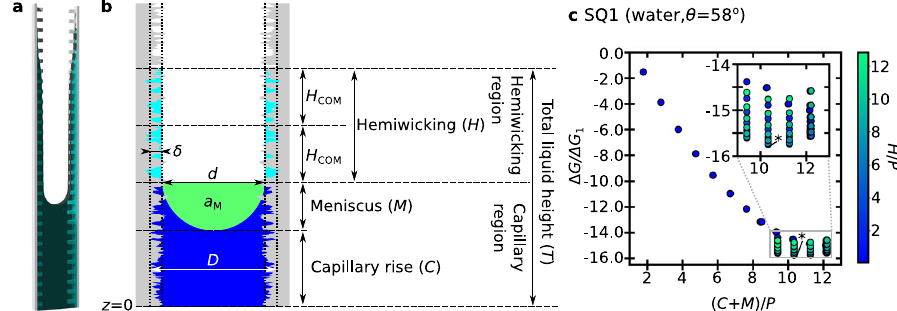
Fig. 1 De fi ning the equilibrium rise heights in rough capillary rise. a Archetypal simulated rise heights in a rough parallel plate setup, exhibiting capillary rise between the surfaces, a meniscus, and hemiwicking within the roughness. b De fi nition of the model geometric parameters. Shown are the rise heights of the: capillary rise C , meniscus M , hemiwicking H , centre of mass of hemiwicking liquid H COM , and total liquid height T . Also shown are the length scales of the: average roughness depth δ , average distance between hemiwicking columns d , and average total plate separation D . The area above the meniscus in the capillary region is denoted a M . Precise descriptions of all parameters are given in the text. c Plot of all metastable, pinned states observed for the simulated system SQ1 (detailed in methods, Table 4), featuring square posts with water as the rising liquid, d / δ = 5.43, and contact angle θ = 58 ∘ . The vertical scale shows the reduced energy variation ( Δ G ) when raising liquid from the reservoir to each unique pinned state, normalised against the energy of hemiwicking a single pitch length in the absence of gravity ( Δ G 1 ). The normalised rise heights in the capillary region and hemiwicking region are indicated on the horizontal axis and colour scale respectively. The magni fi ed inset highlights the density of metastable states around the global minimum energy state (the equilibrium state), indicated by ‘ * ’ Table 1 The roughness parameters for a pillared texture, where the shape parameter α = 1 for square pillars, and α = π /4 for cylindrical pillars.